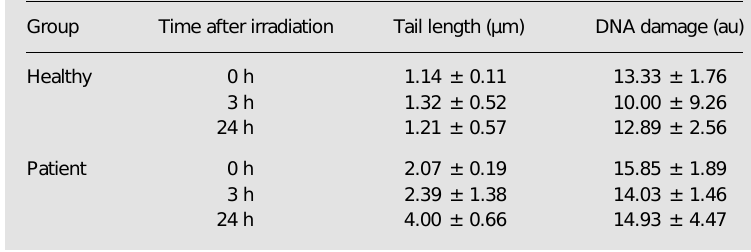
1 - Basal values obtained by the comet assay for blood samples from 3 healthy donors and 3 breast cancer patients. Data are reported as means ±